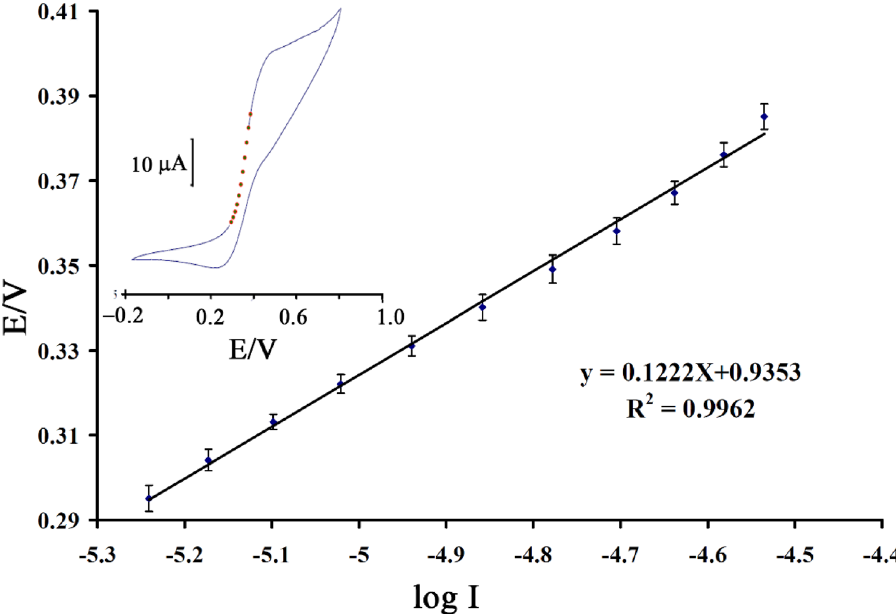
Figure 5. Tafel plots for the BPOFc/BMPF6/NiO-SWCNTs/CPE (pH 7.0) at the scan rate of 20.0 mV/s in the presence of 1.0 mM N-acetylcysteine (n = 3).